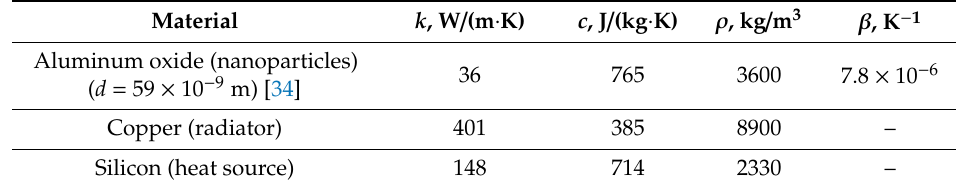
Table 1. Properties of nanoparticles and other materials.